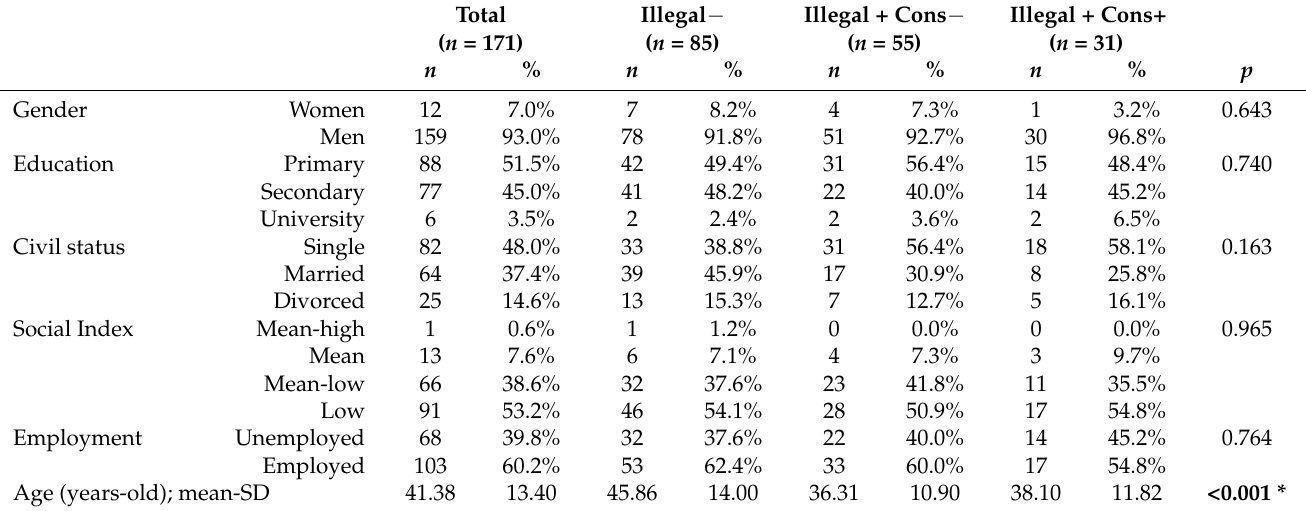
Table 1. Comparison between the groups for sociodemographic